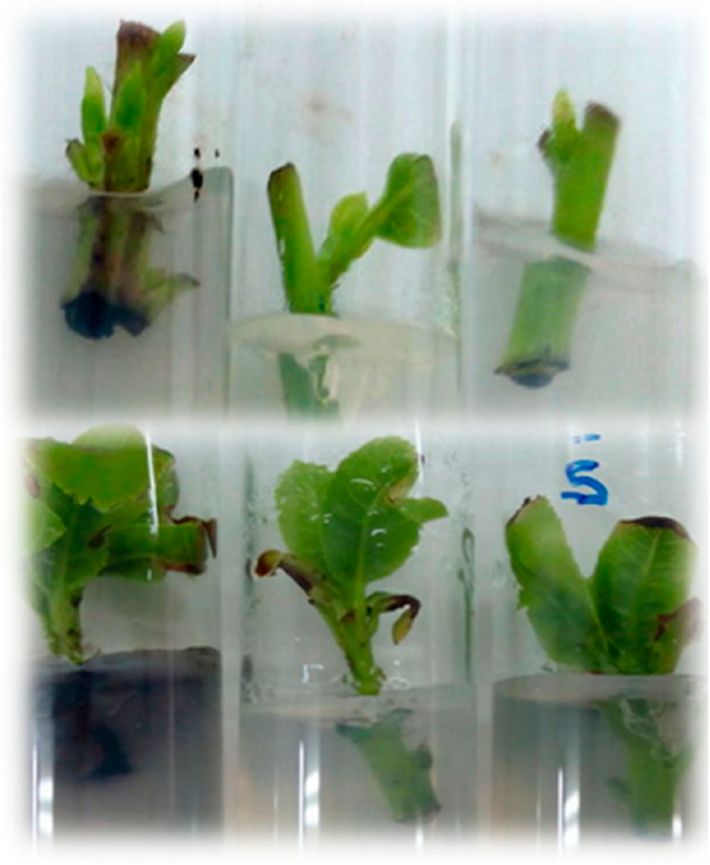
Figure 3. Axillary shoot formation from nodium and shoot tip